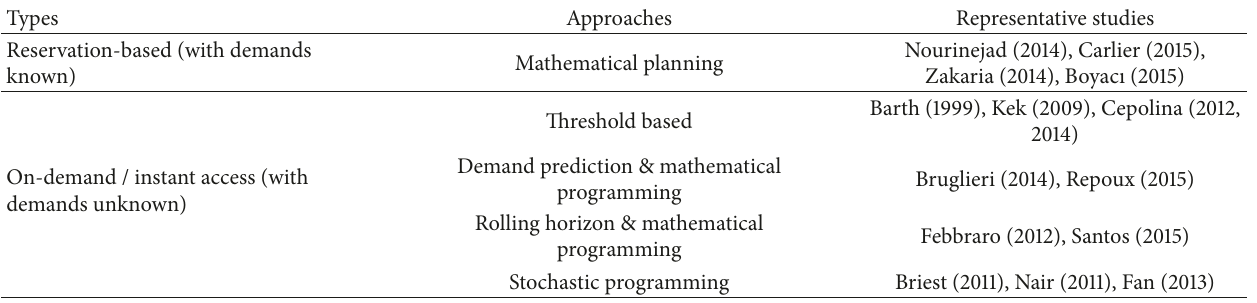
Table 1: Summary of studies on vehicle relocation of carsharing